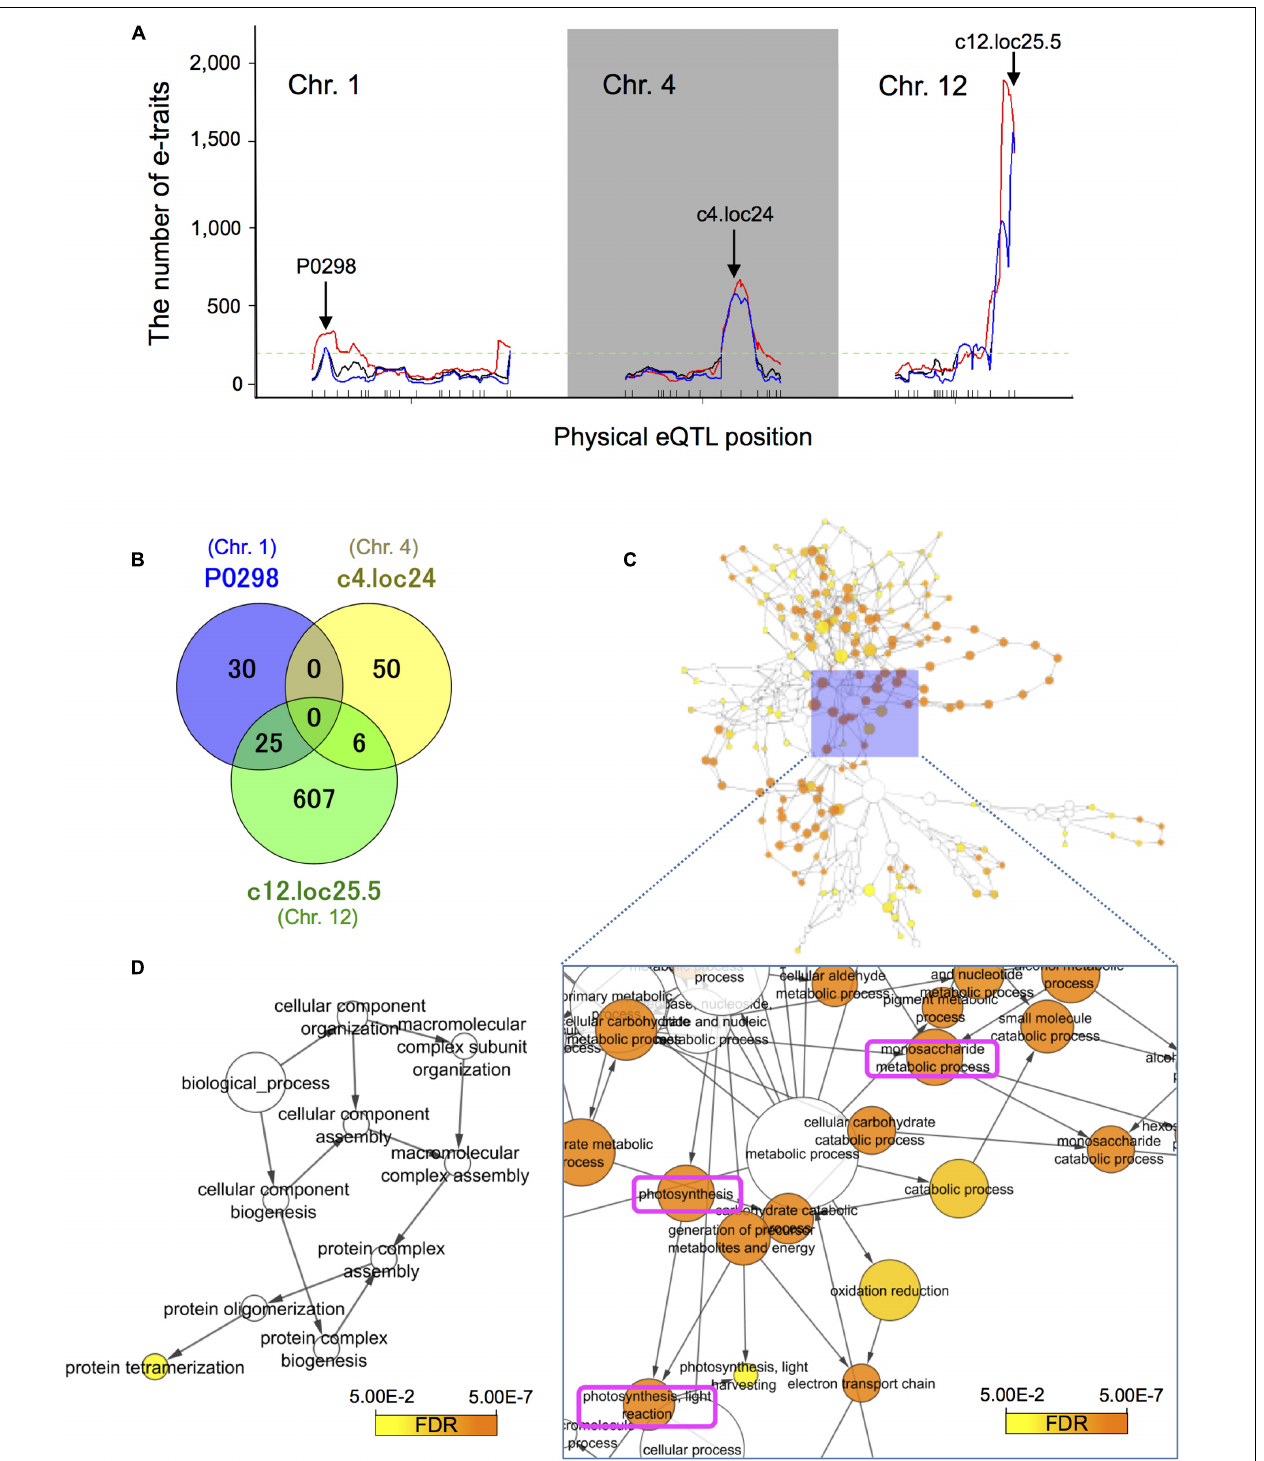
FIGURE 4 | Expression quantitative trait loci hotspot size significance profile and functional assessment of genes with trans -eQTLs. (A) The major significant eQTL hotspots were derived with a quantile-based permutation approach (Neto et al., 2012). All permutation thresholds were calculated targeting a genome-wide error rate (GWER) < 0.05. The major hotspots on chromosomes 1, 4, and 12 were identified. Arrows indicate the (pseudo-)marker name of the maximum LOD peak. Black lines represent raw eQTL counts, red identifies counts smoothed over a 5 cM window, and blue the sliding LOD threshold approach. The horizontal